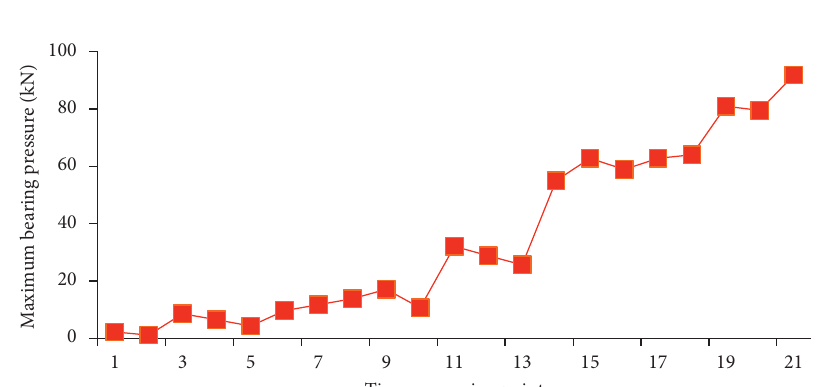
Figure 21: Vertical displacement of roof strata.